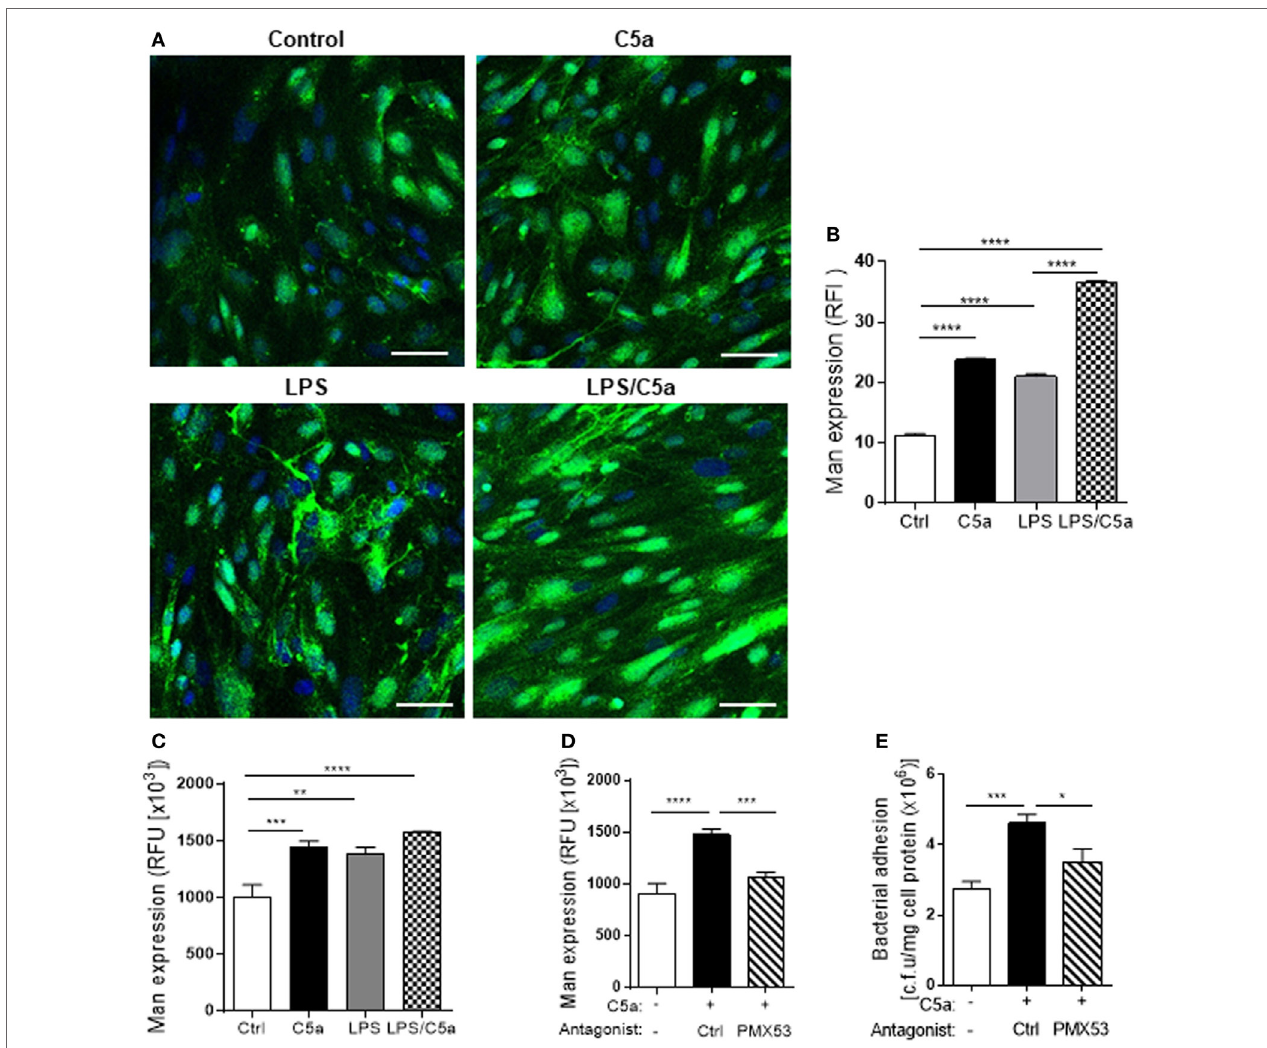
FigUre 4 | C5a stimulation upregulates Man expression in renal tubular epithelial cell (RTEC). RTEC were pre-treated with C5a (10 nM) and/or LPS (800 ng/mL) or with C5a, in the presence of C5aR1 antagonist (PMX53, 5 µM) or vehicle (Ctrl) for 24 h and subjected to assessment of Man expression and bacteria binding to RTEC. (a,B) Fluorescence microscopy analysis. (a) Representative fluorescence images of Man expression in RTEC (non-permeabilized). Man (green) detected by fluorescein-labeled Galanthus nivalis lectin (GNL) and 4’,6-diamidino-2-phenylindole (blue) are shown. Scale bars, 25 µm. (B) Quantification of Man expression, shown as relative fluorescence intensity in GNL-positively stained area corresponding to the images shown in (a) . (c,D) Fluorescence intensity-based microplate assay. (c) Man expression in RTEC that had been treated with C5a and/or LPS. (D) Man expression in RTEC that had been treated with C5a and PMX53. (e) Bacterial adhesion to RTEC, evaluated by bacterial plate count assay. (B–D) Data were analyzed by one-way ANOVA with Tukey’s multiple comparisons [ (B) n = 6 coverslips per group, under × 100 magnification, (c) n = 9 individual wells per group, (D,e) n = 6–8 individual wells per group]. All results shown are representative of three independent experiments. * P < 0.05, ** P < 0.01, *** P < 0.001, **** P < 0.0001. Abbreviations: Ctrl, control; RFI, relative fluorescence intensity; RFU, relative fluorescence